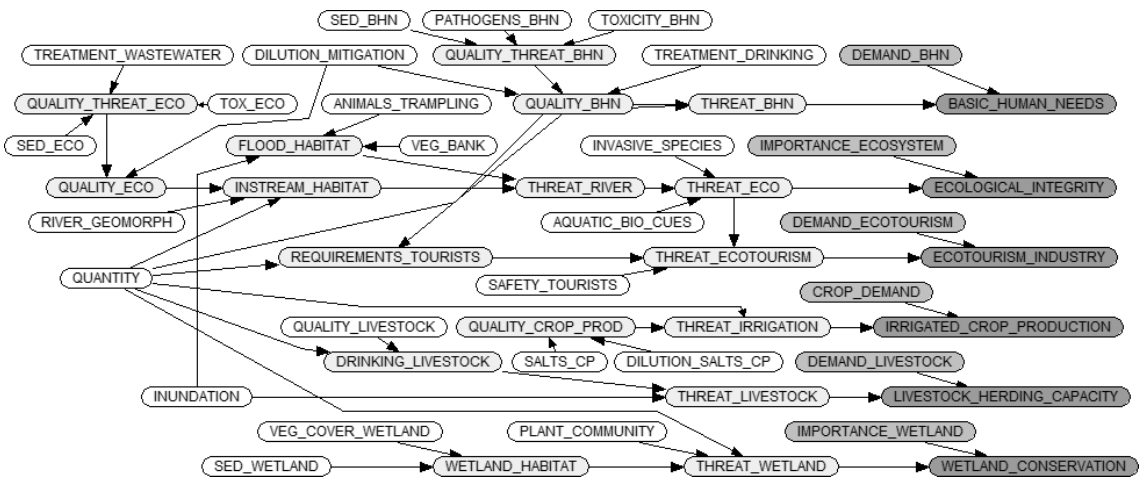
Figure 6. Bayesian network models used in the Mara River case study to evaluate the risk of water resource use to a range of socio- ecological endpoints. White nodes represent input exposure variables, light grey nodes complete the expose leg of the risk assessment, grey nodes represent effect leg of models and dark grey nodes represent endpoints. Working Netica ™ models are provided in the